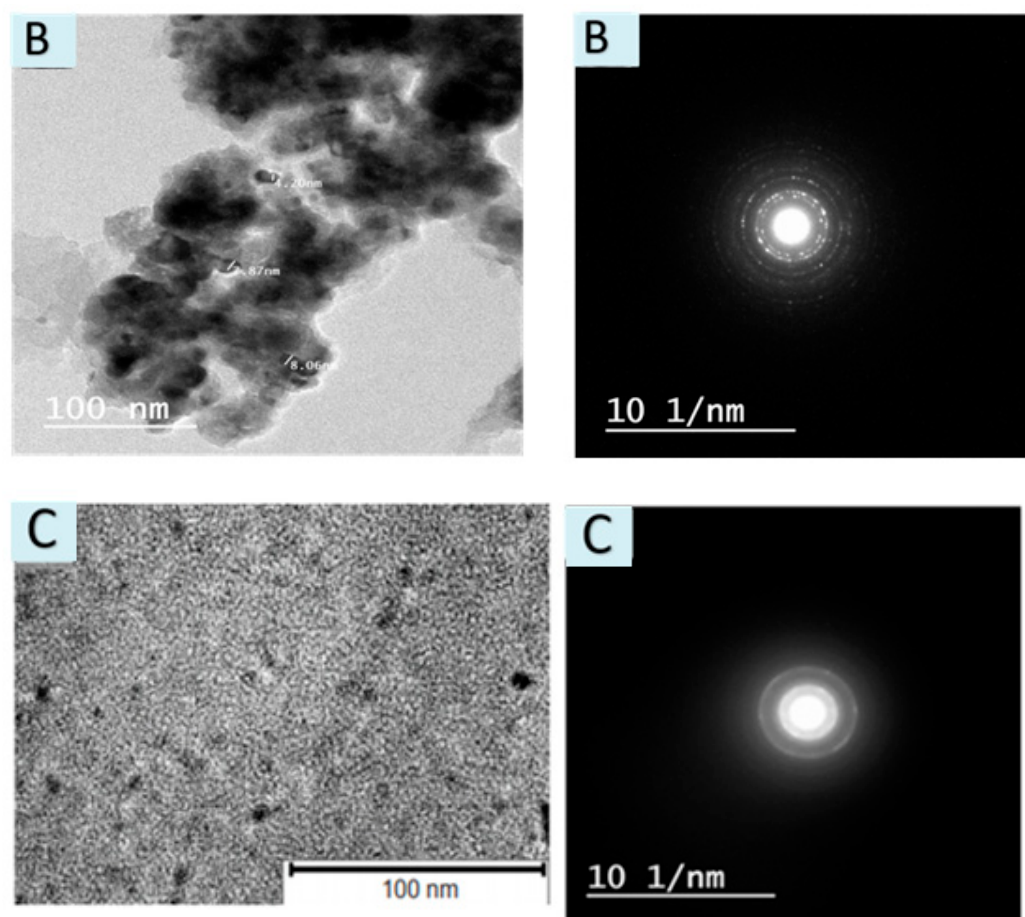
Figure 4. Transmission electron microscopy (TEM) and selected area electron diffraction (SAED) pattern for ( A ) nNiO/Acell, ( B ) nCuO/PAC and ( C ) nFe3O4/Acell nanocomposites.